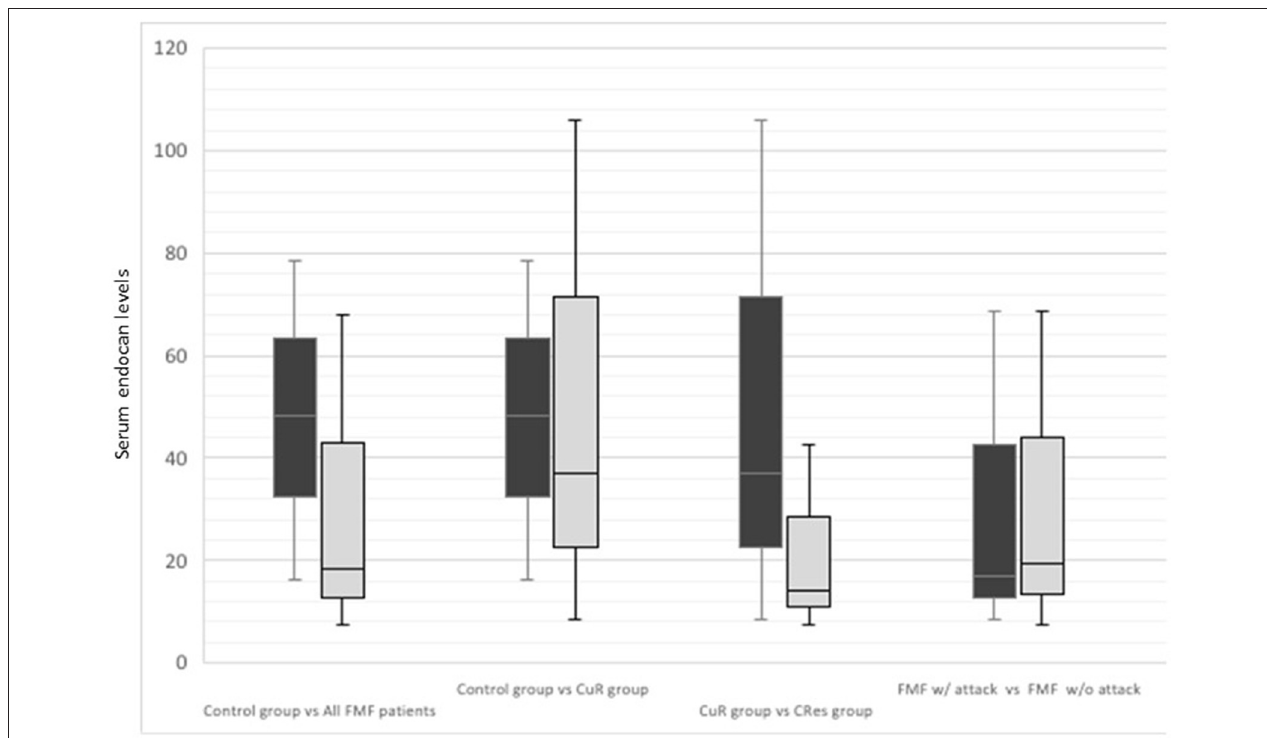
FIGURE 1 | The comparison of the endocan levels among control group and all familial Mediterranean fever patients’ subgroups.